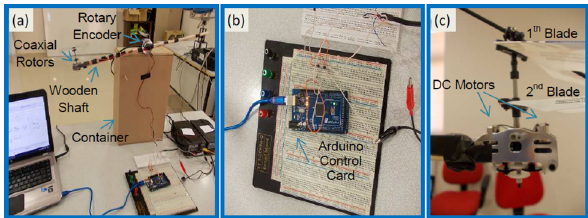
Fig 12. (a) A prototype of coaxialrotors control experimental test platform; (b) Close views of ArduinoMega 2560 card; (c) Close views of coaxialrotors and bladesused in the experimental